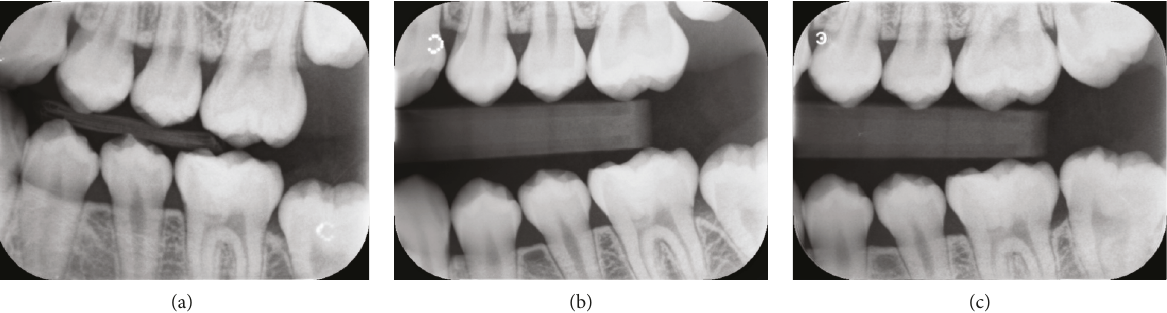
Figure 3: Bitewing radiographs recorded (a) three years postoperative, (b) four years postoperative, and (c) fi ve years postoperative, showing dentine bridge in the left mandibular permanent fi rst